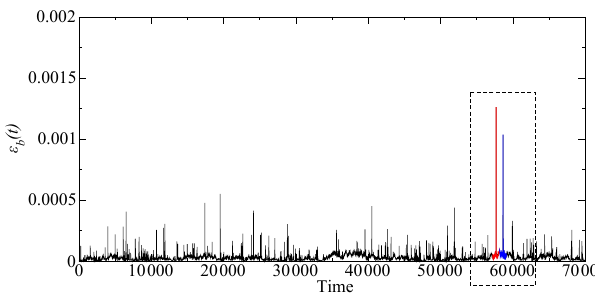
Figure 6. Time series of (cid:15) b (t) , Eq. (5), with ν = η = 10 − 4 in the shell model. The red and blue regions inside the dashed box corre- spond to an active state, as explained later in the text. (Taken from Domínguez et al.,